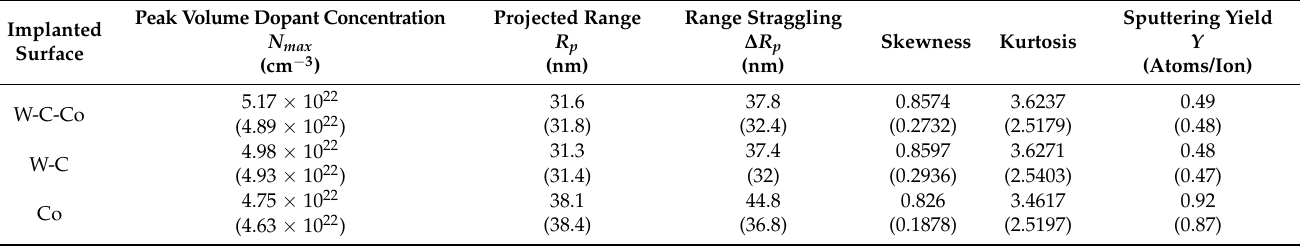
Table 2. Values of the parameters of nitrogen peak and the sputtering yield.